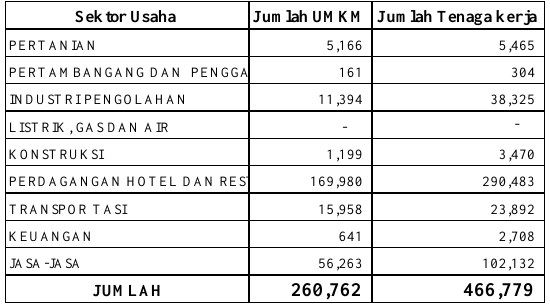
Tabel 1.1. Data Start-up Bisnis/UMKM Kota Surabaya